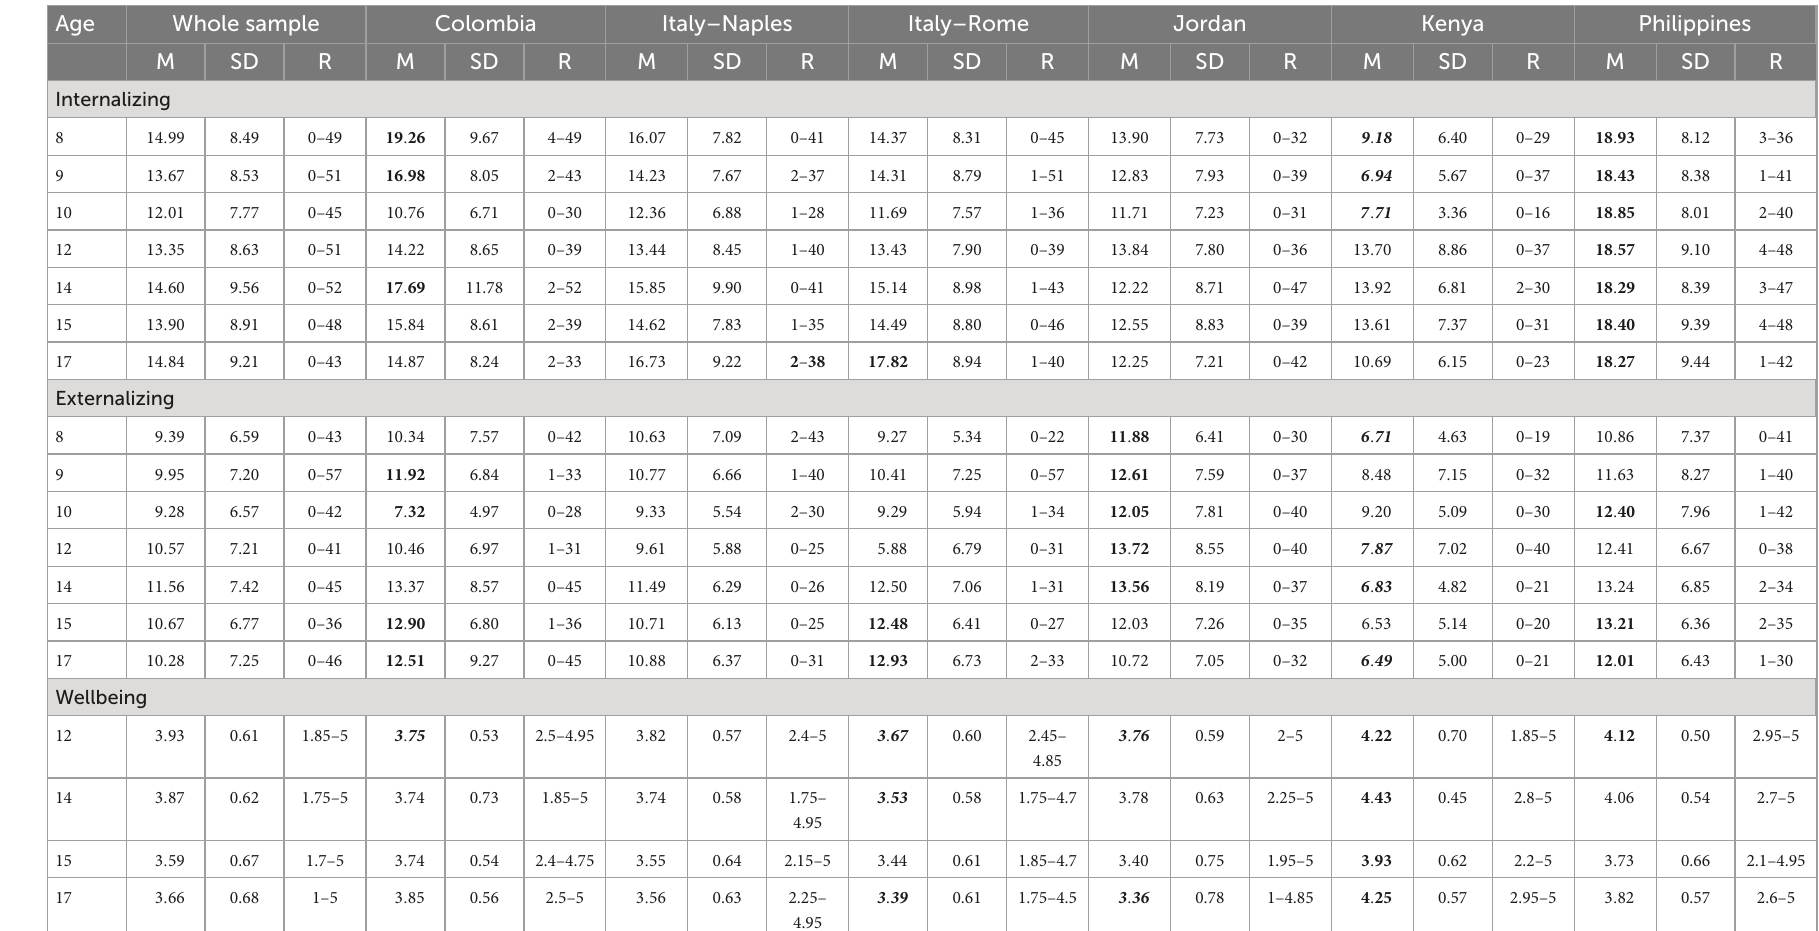
TABLE 1 Descriptive statistics for substantive measures at ages 8–10, 12, 14–15, and 17 by cultural